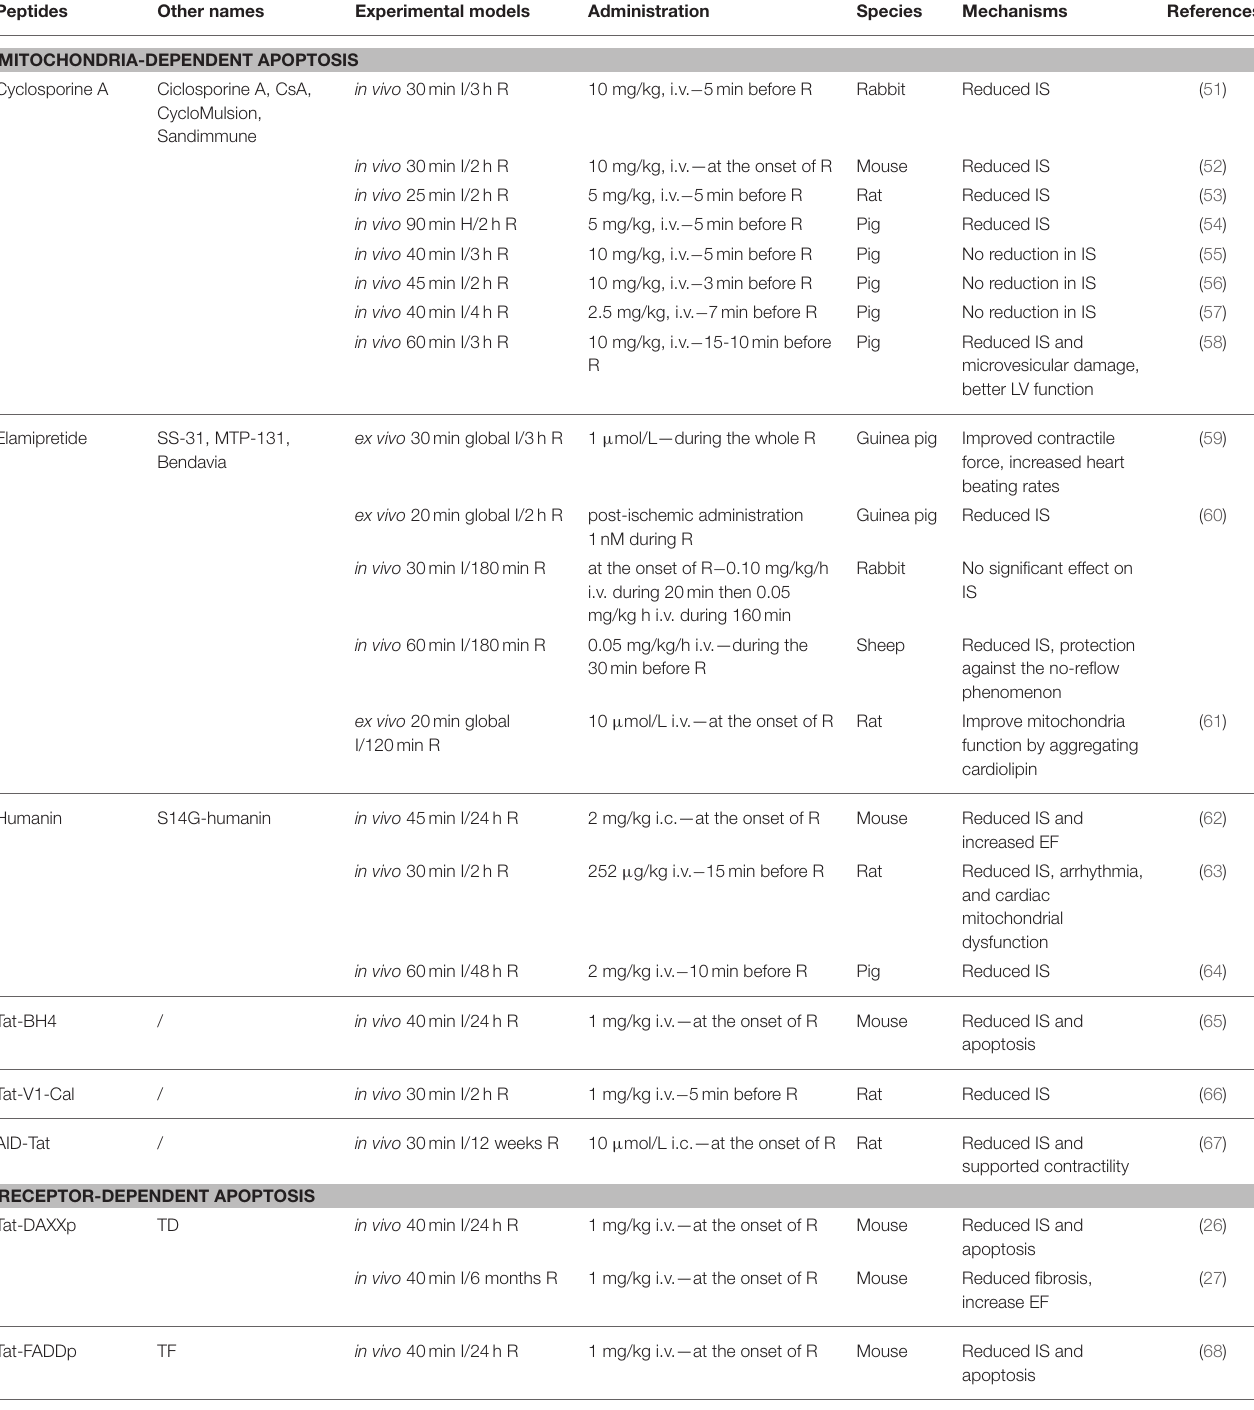
TABLE 1 | Therapeutic peptides used in different IR animal models mentioned in this review.